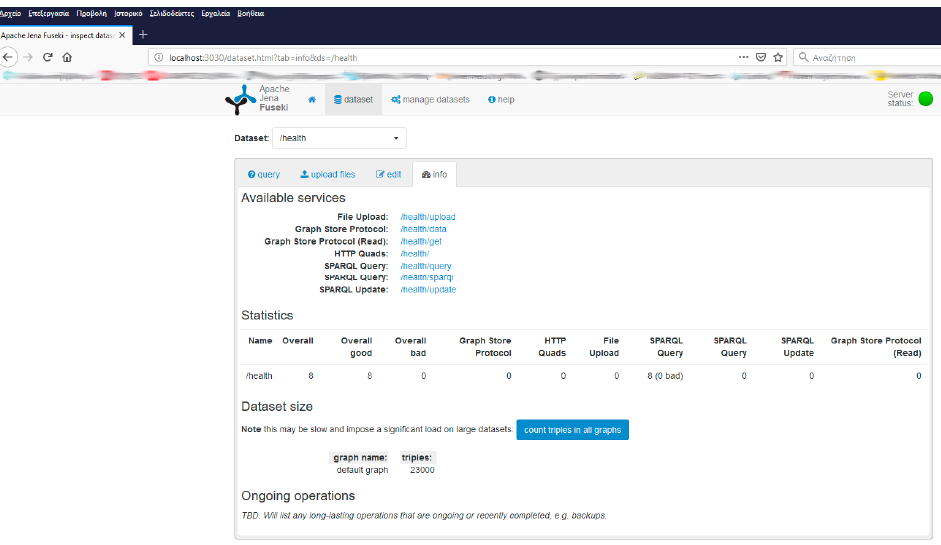
Figure 3. An overview of the database.